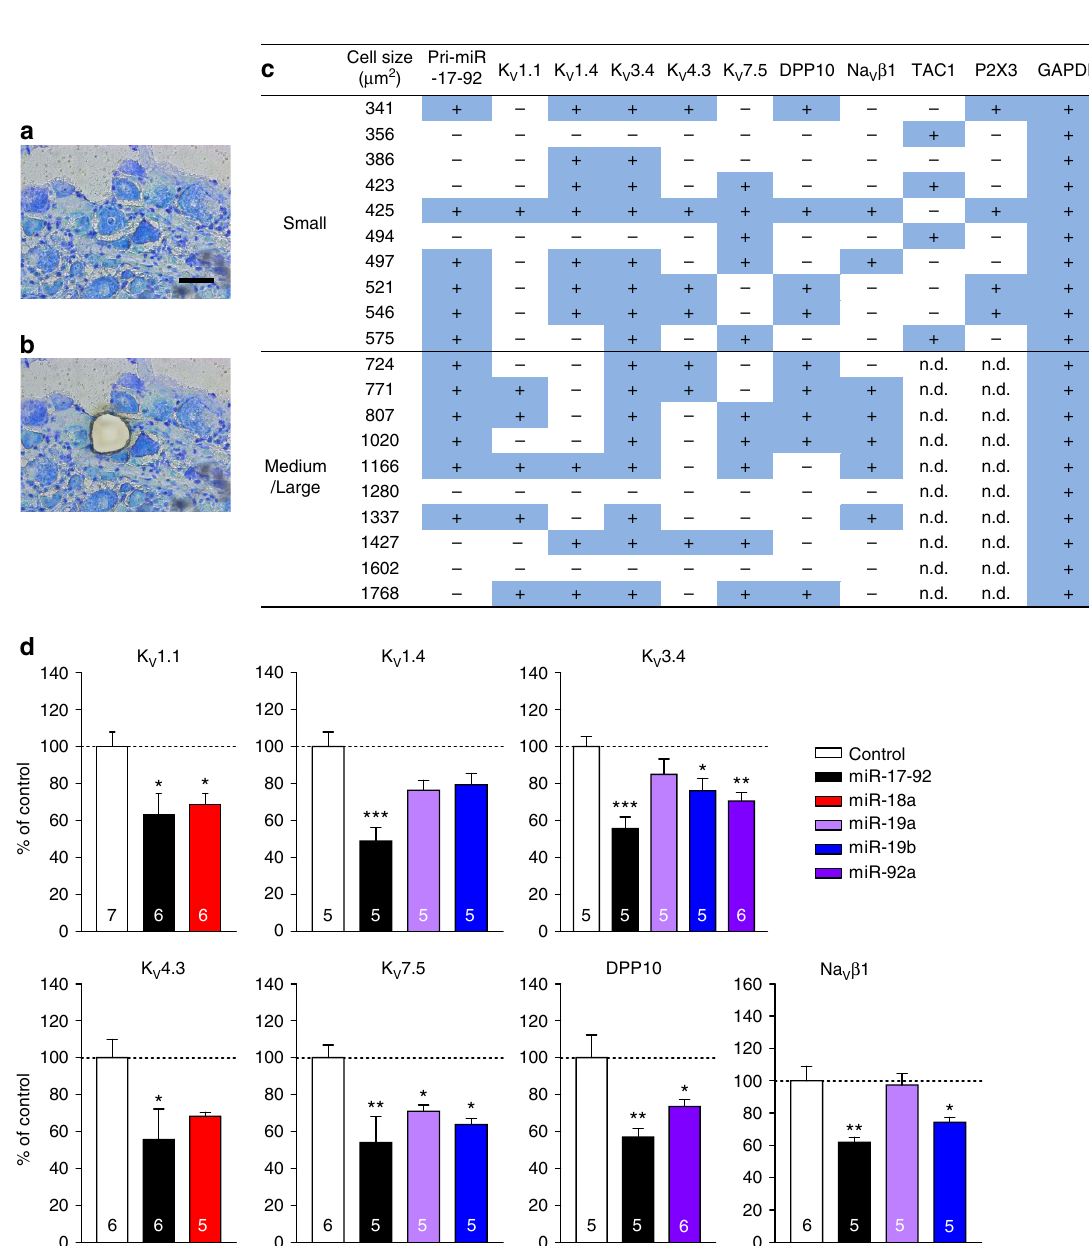
Figure 5 | miR-17-92 cluster members differentially inhibit expression of voltage-gated potassium channel subunits in vivo . ( a , b ) Representative images of L5 DRG stained with toluidine blue before ( a ) and after ( b ) laser-captured microdissection. Scale bar, 50 m m. ( c ) Expression profile of pri-miR-17-92 and voltage-gated potassium channel subunits in a single DRG neuron of indicated cell size; DRG neurons o 600 m m 2 and 4 600 m m 2 were considered to be small and medium/large neurons, respectively. n.d.; not determined. ( d ) Expression of voltage-gated potassium channel subunit mRNAs examined in the L5 DRG 7 days after control or miR-17-92 AAV vector administration. Numbers of samples are indicated at the base of each bar. Error bars are s.e.m. * P o 0.05, ** P o 0.01 and *** P o 0.001 (K V 1.1, P ¼ 0.014 for miR-17-92 and P ¼ 0.034 for miR-18a; K V 1.4, P o 0.001 for miR-17-92; K V 3.4, P o 0.001 for miR-17-92, P ¼ 0.047 for miR-19b and P ¼ 0.009 for miR-92a; K V 4.3, P ¼ 0.031 for miR-17-92; K V 7.5, P ¼ 0.002 for miR-17-92, P ¼ 0.048 for miR-19a and P ¼ 0.013 for miR-19b; DPP10, P ¼ 0.003 for miR-17-92 and P ¼ 0.043 for miR-92a; Na V b 1, P ¼ 0.002 for miR-17-92 and P ¼ 0.030 for miR-19b), Dunnett’s